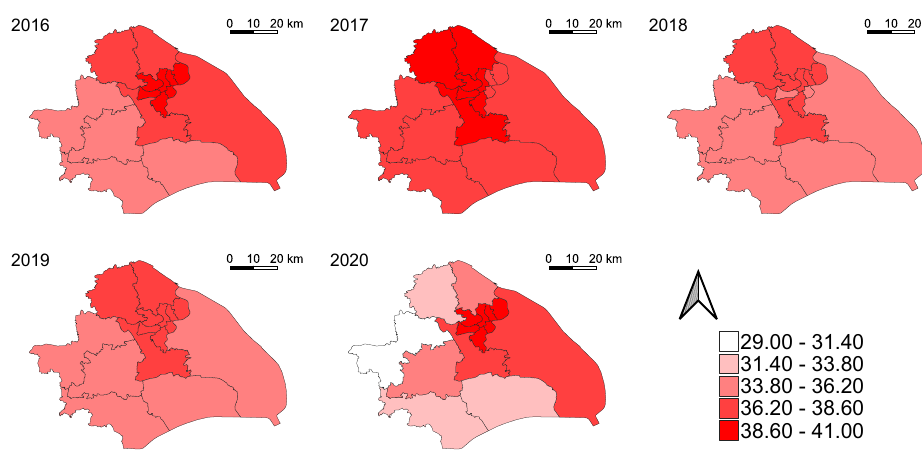
Figure 14. Average value of Heat in each district.